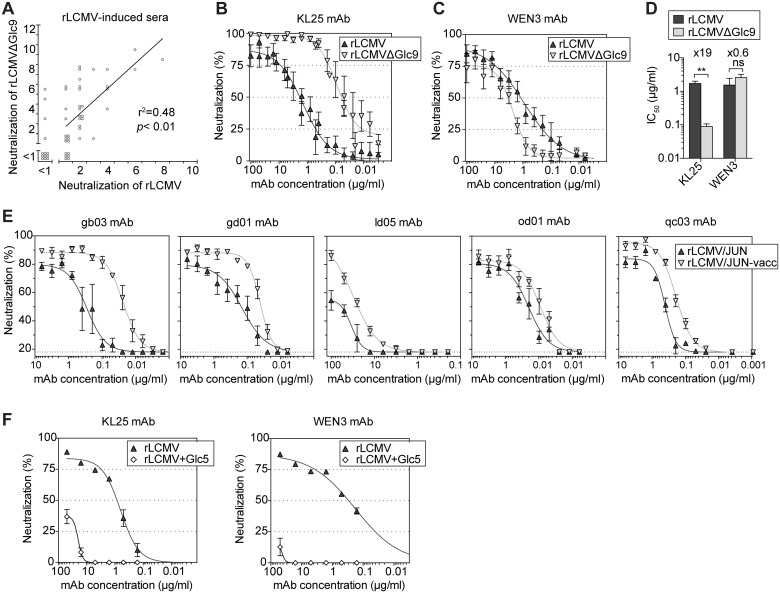
Monoclonal Abs neutralize preferentially GP-1 variants that lack specific glycans.(A) We infected C57BL/6 mice with rLCMV (105−106 PFU) and collected serum after virus clearance (day 40–80). We assessed neutralizing activity against the immunizing rLCMV and against the partially deglycosylated variant rLCMVΔGlc9. Each point represents an individual mouse serum sample. Data from 53 mice in nine independent experiments are summarized. The Pearson’s correlation coefficient and two-tailed p-value are indicated. ** p<0.01. (B-D) We quantified the neutralization potency of KL25 and WEN3 mAbs against rLCMV (wt GP) and rLCMVΔGlc9, respectively (B-C), and determined half-maximal inhibitory concentrations (IC50, D). The mean ±SEM of 7 data points recorded in 5 independent experiments is represented. Unpaired student’s t-tests were used for statistics. ** p<0.01. (E) The neutralization potency of 5 mAbs elicited by WT JUNV [45] was individually assessed against rLCMV/JUN (wt GP; four GP-1 glycosylation motifs) or rLCMV/JUN-vacc (three GP-1 glycosylation motifs). Symbols represent the mean ±SEM of 3 replicates per group. One representative out of three experiments is shown. (F) We used KL25 and WEN3 mAbs in neutralization assays against rLCMV (wt GP) and an rLCMV variant in which Glc5 was artificially introduced (rLCMV+Glc5). Symbols represent the mean ±SEM of 3 replicates.